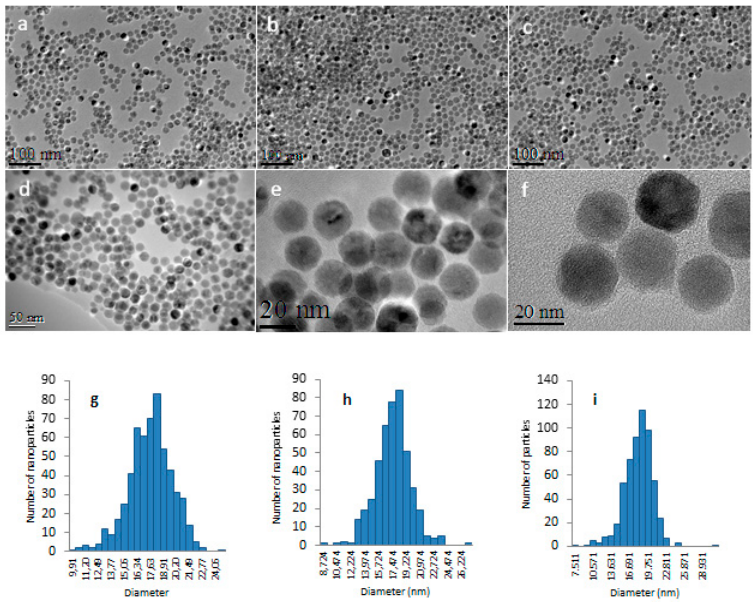
Figure 5. ( a – f ) Transmission electron microscope (TEM) images of IO-NPs. ( g – i ) Histograms of the a, b and c TEM images respectively. The mean diameter and standard deviations are: ( g ) 17.264 nm ± 2.3%, ( h ) 17.087 nm ± 2.2% and ( i ) 17.339 nm ± 3.28%.